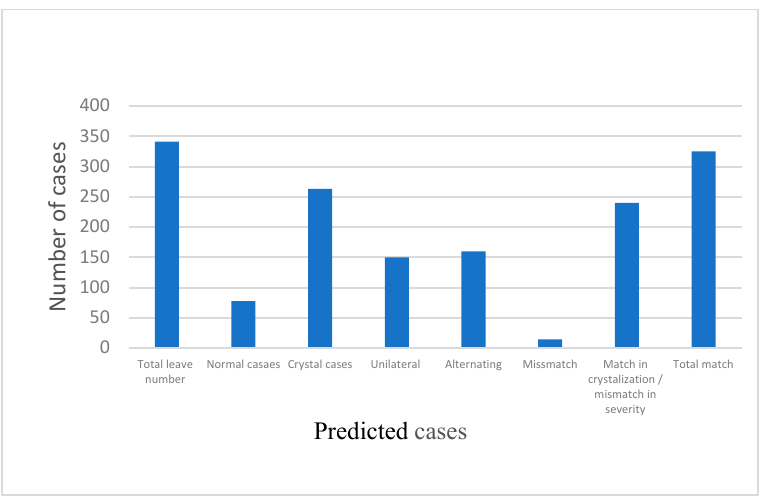
Figure 9. Distribution of cases.